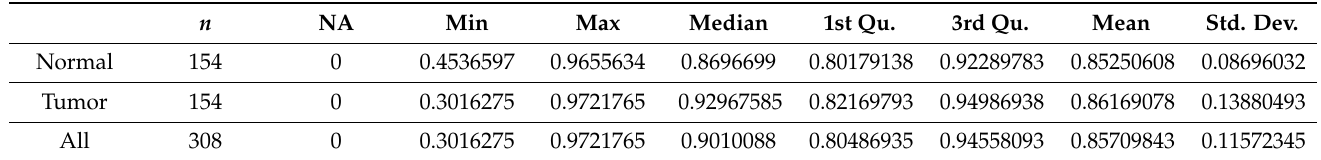
Table 4. KIRP β -values and